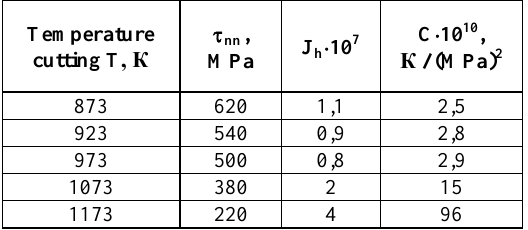
Table 2. Milling of steel 30HGSA (HRCэ 35 ... 38) single- tooth end mill T15K6; cutting speed